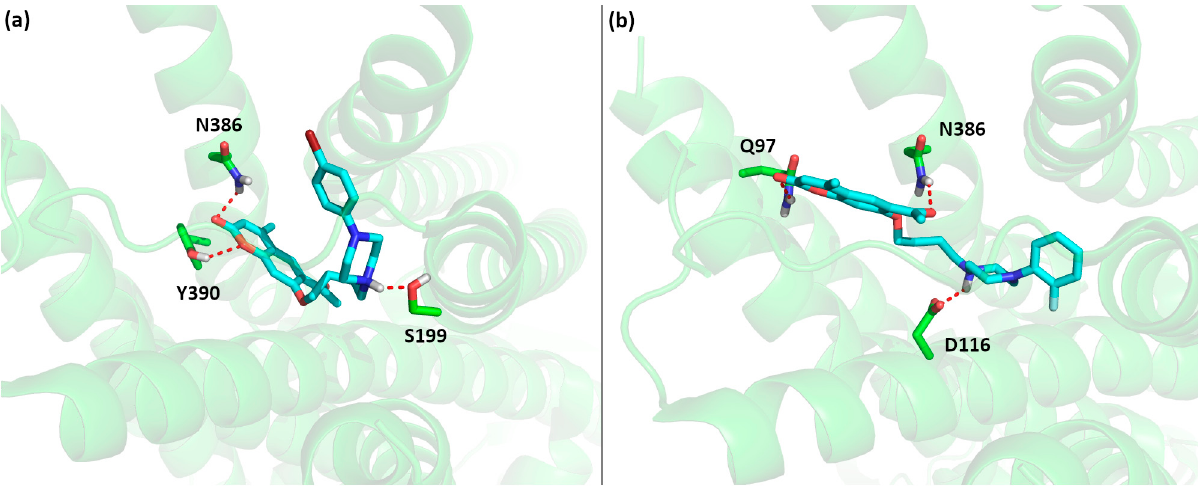
Figure 4. Predicted pose of ( a ) 7 and ( b ) experimental pose aripiprazole inside the binding pocket of the 5-HT 1A receptor, highlighting the most important interactions between ligands and the receptor (salt bridge between the ligand and D116 and hydrogen bond between the ligand and Q97). Oxygen atoms are shown in red, nitrogen in blue, carbon in cyan or green and hydrogen in light